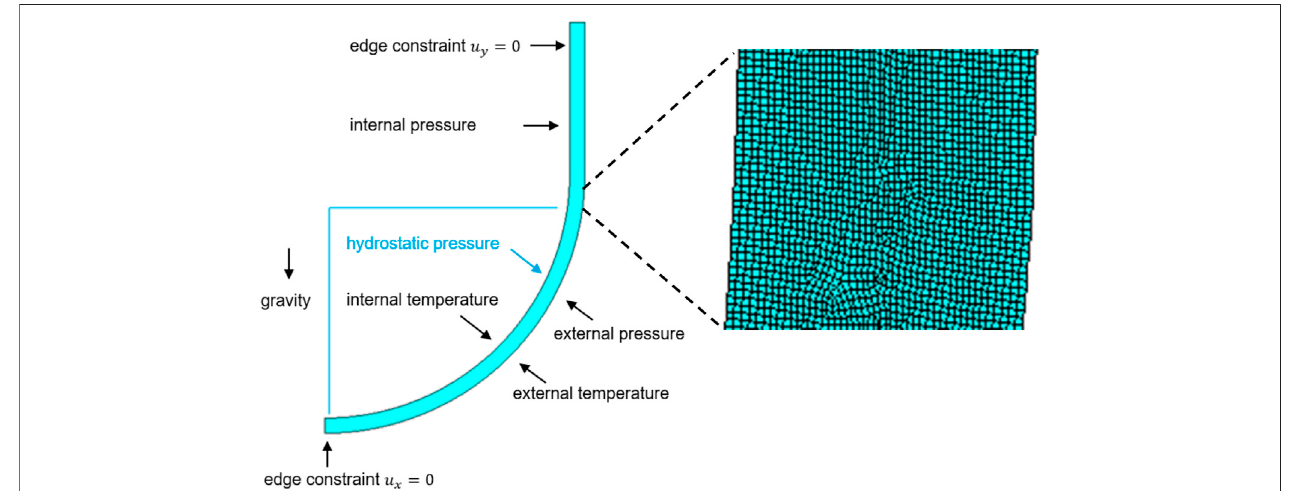
FIGURE 3 | 2D axisymmetric geometry of the ablated RPV, loads, constraints, and the mesh.